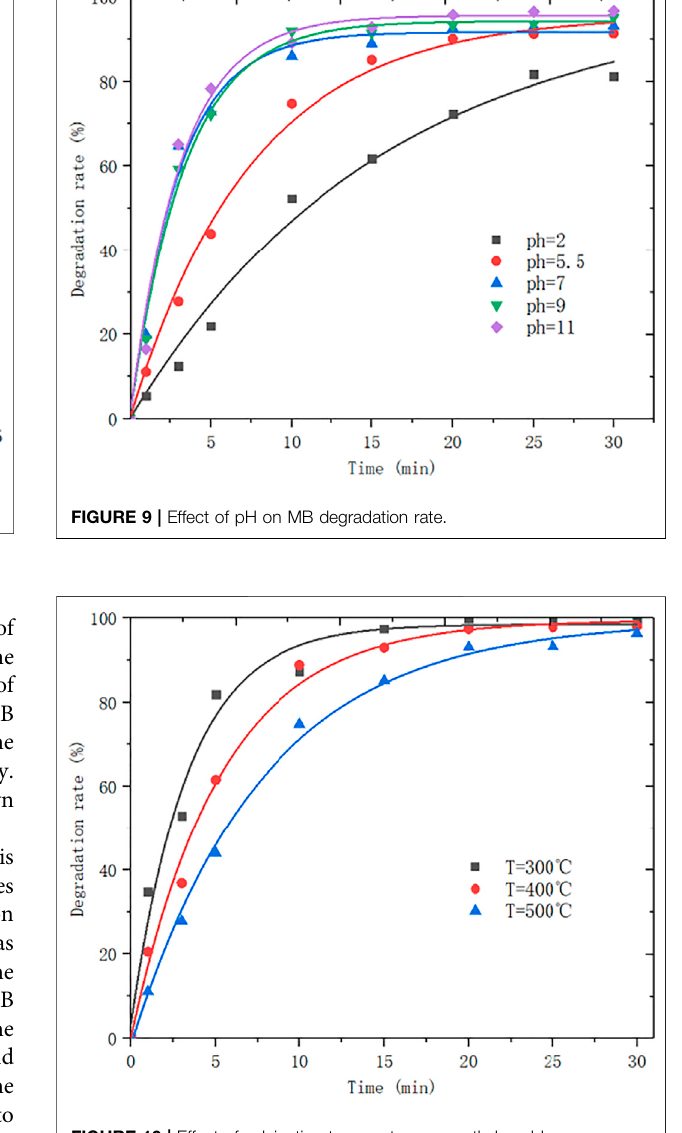
FIGURE 10 | Effect of calcination temperature on methylene blue